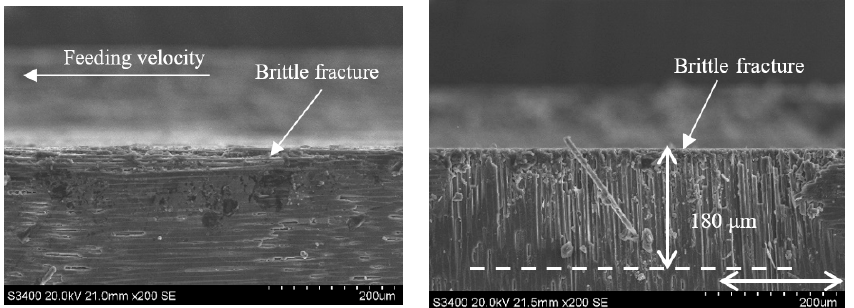
Figure 19. Grinding subsurface topography of the UAG-C/SiC composite (v s = 1.26 m/s, a p = 0.4 mm, v w = 100 m/min).